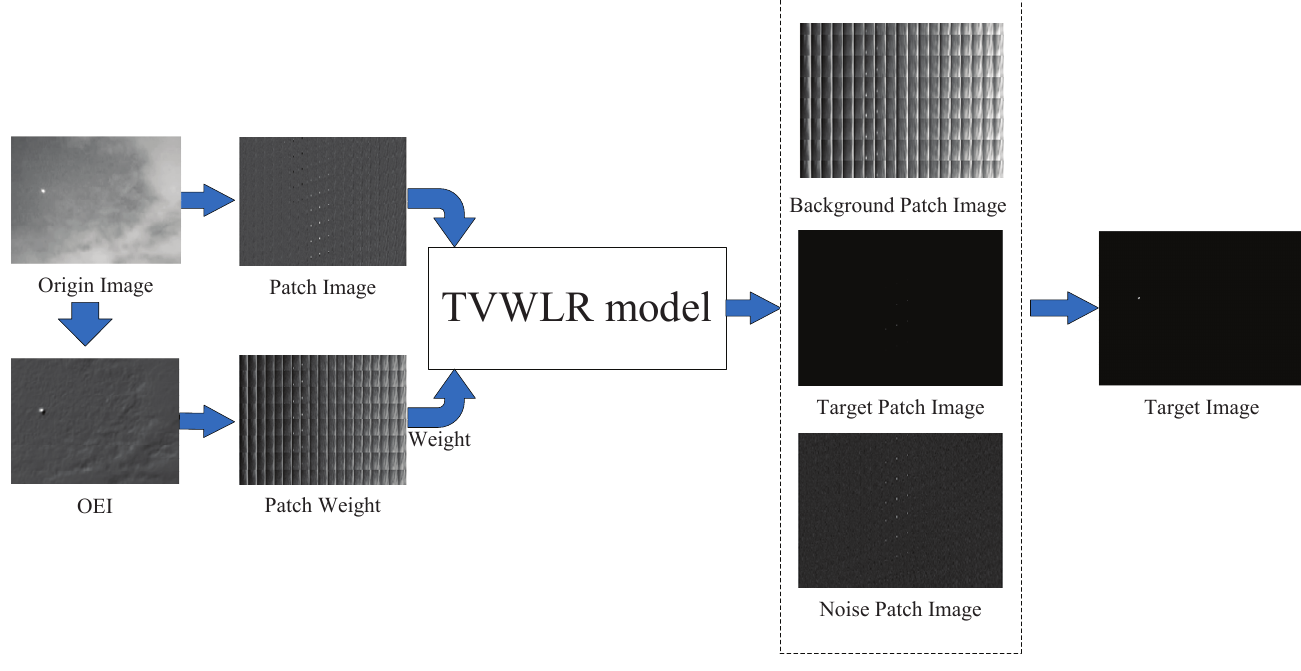
Figure 3. The framework of the proposed